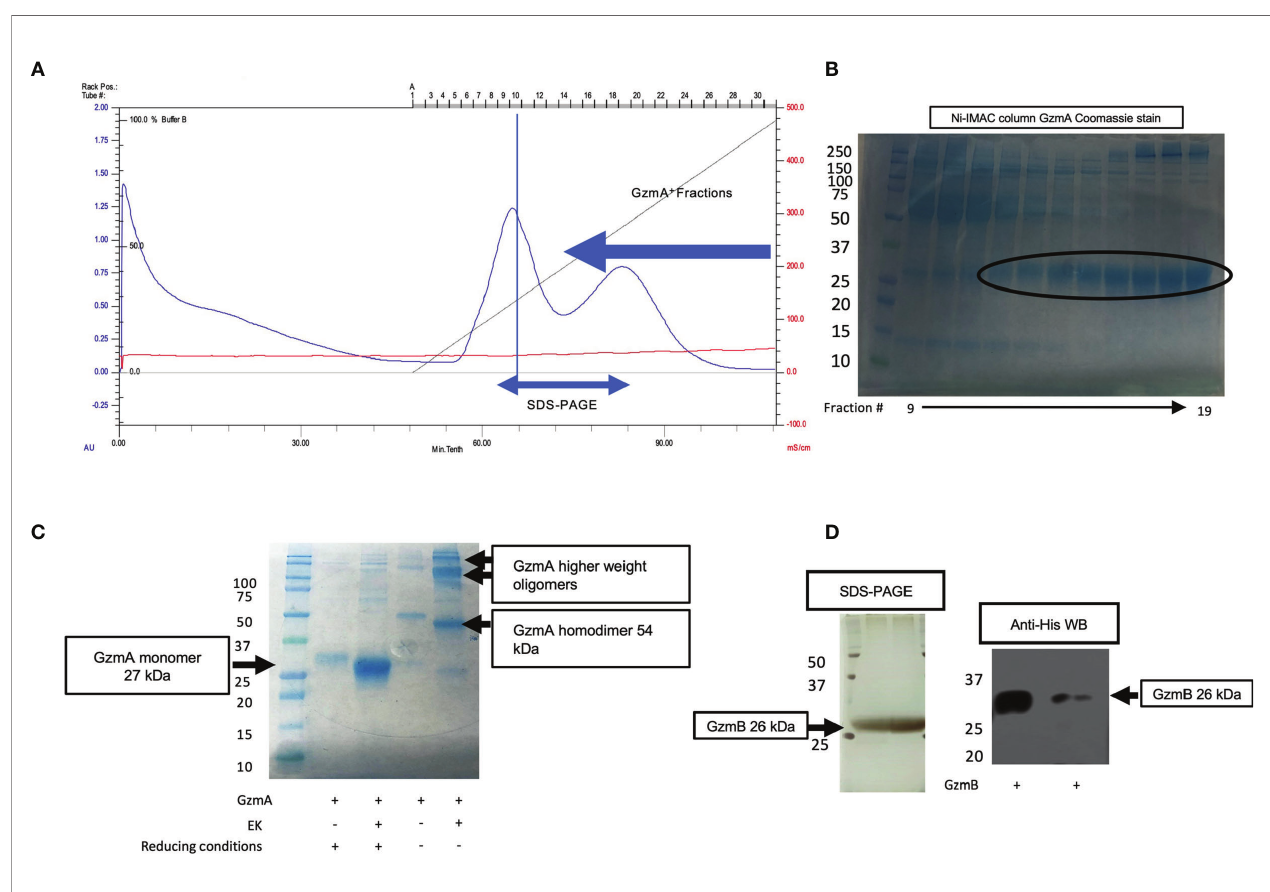
FIGURE 2 | Ni-IMAC puri fi cation and EK activation of Gzms. (A) Representative chromatogram of a Ni-IMAC column run for GzmA (similar layout for GzmB) showing elution of serum proteins fi rst (starting at fraction 6, peaking at 10), then elution of GzmA + fractions (starting at fraction 13 and ending at fraction 28). (B) Coomassie stained SDS-PAGE under reducing conditions (GzmA monomer pre-EK activation runs at 31 kDa). On the left, Molecular Weight (MW) markers. (C) Example of band shift for GzmA following EK activation after overnight incubation. GzmA monomer on the left (under reducing conditions) transitions from 31 kDa to 27 kDa, while GzmA homodimer on the right transitions from 62 kDa to 54 kDa. Other bands other than GzmA monomer and homodimer re fl ect oligomers of GzmA (multiples of GzmA homodimer and of unknown signi fi cance). On the left, MW markers. (D) On the left, loading control of pre and post-EK GzmB by silver staining, and on the right the fi nal product displays a profoundly reduced His-tag as shown for GzmB (26 kDa) by Anti-His WB. The signi fi cantly lower band intensity on the right is indicative of near complete EK cleavage. On the left, MW